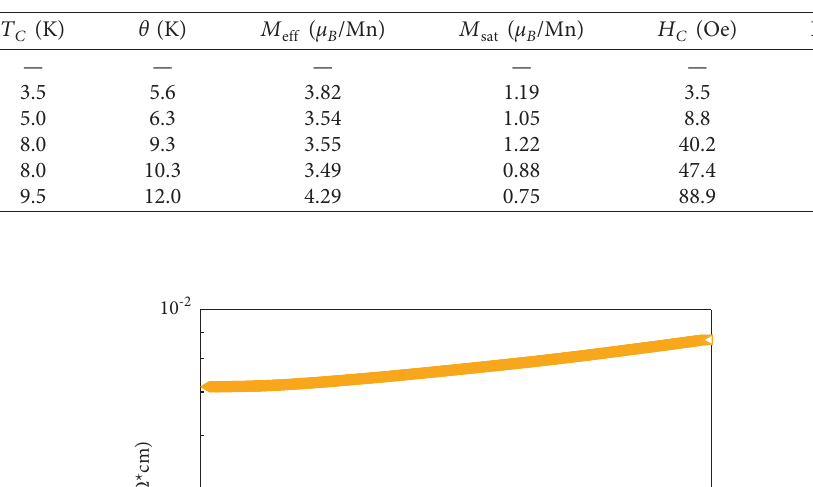
, coercive field H C , and sat